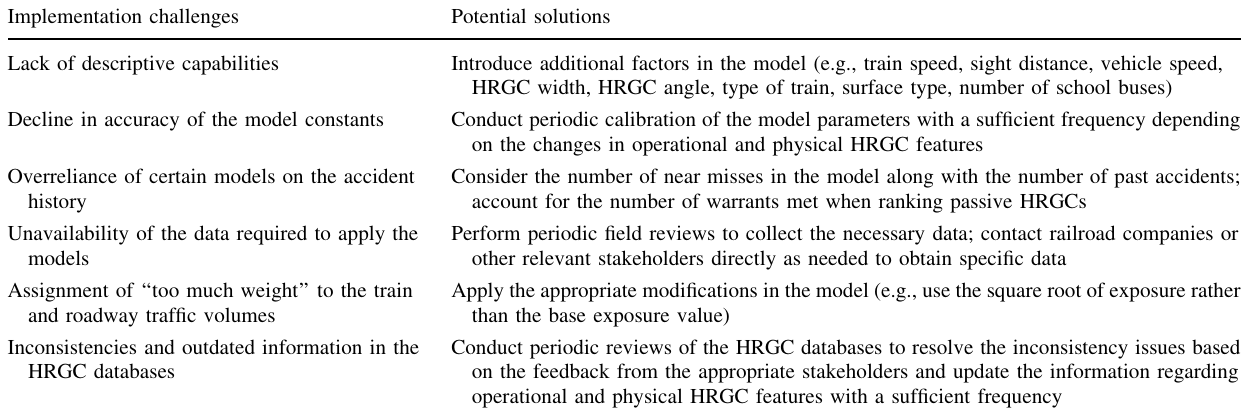
Table 8 Implementation challenges identified and potential solutions proposed Implementation